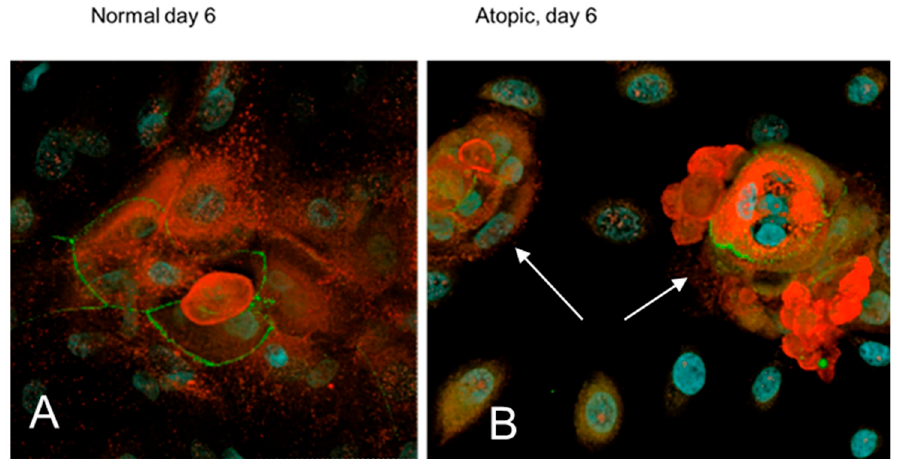
Figure 14. Filaggrin 2 staining (red) in normal ( A ) and atopic ( B ) keratinocytes on D6. Confocal microscopy was performed on Nikon A1RMPsi-STORM4.0 on the 60 X water objective. Atopic keratinocytes ( B ) have formed isolated round accumulation of cells into dome-like structures (white arrows). Green staining shows distribution of occluding and blue staining (DAPI) shows the nucleus.